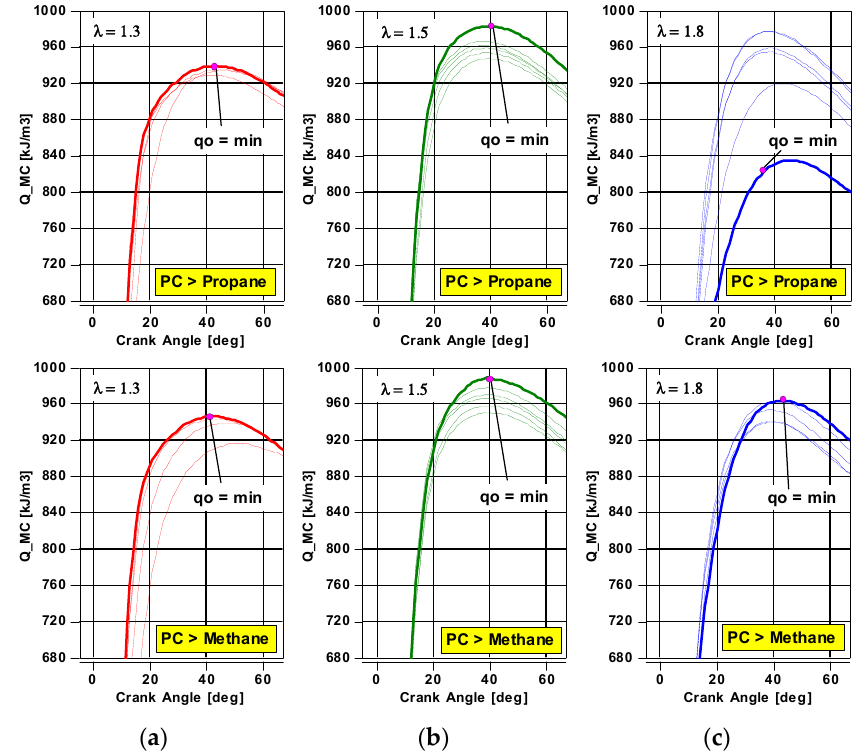
Figure 12. The heat release path in the cylinder (in the main chamber) with the determination of the minimum dose of fuel injected into the prechamber for both types of fuels: ( a ) at λ = 1.3; ( b ) at λ = 1.5; ( c ) at λ = 1.8.